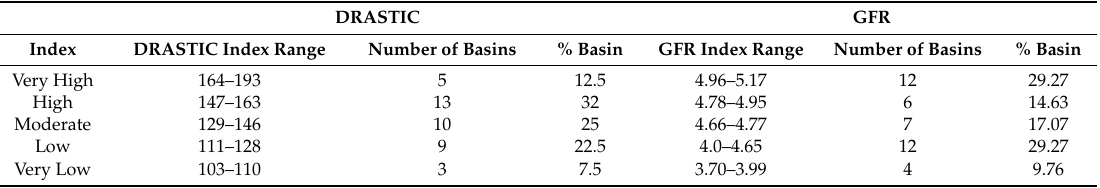
Figure 18. Histogram of DRASTIC Index values. Table 7. Natural Breaks classification of DRASTIC and GFR